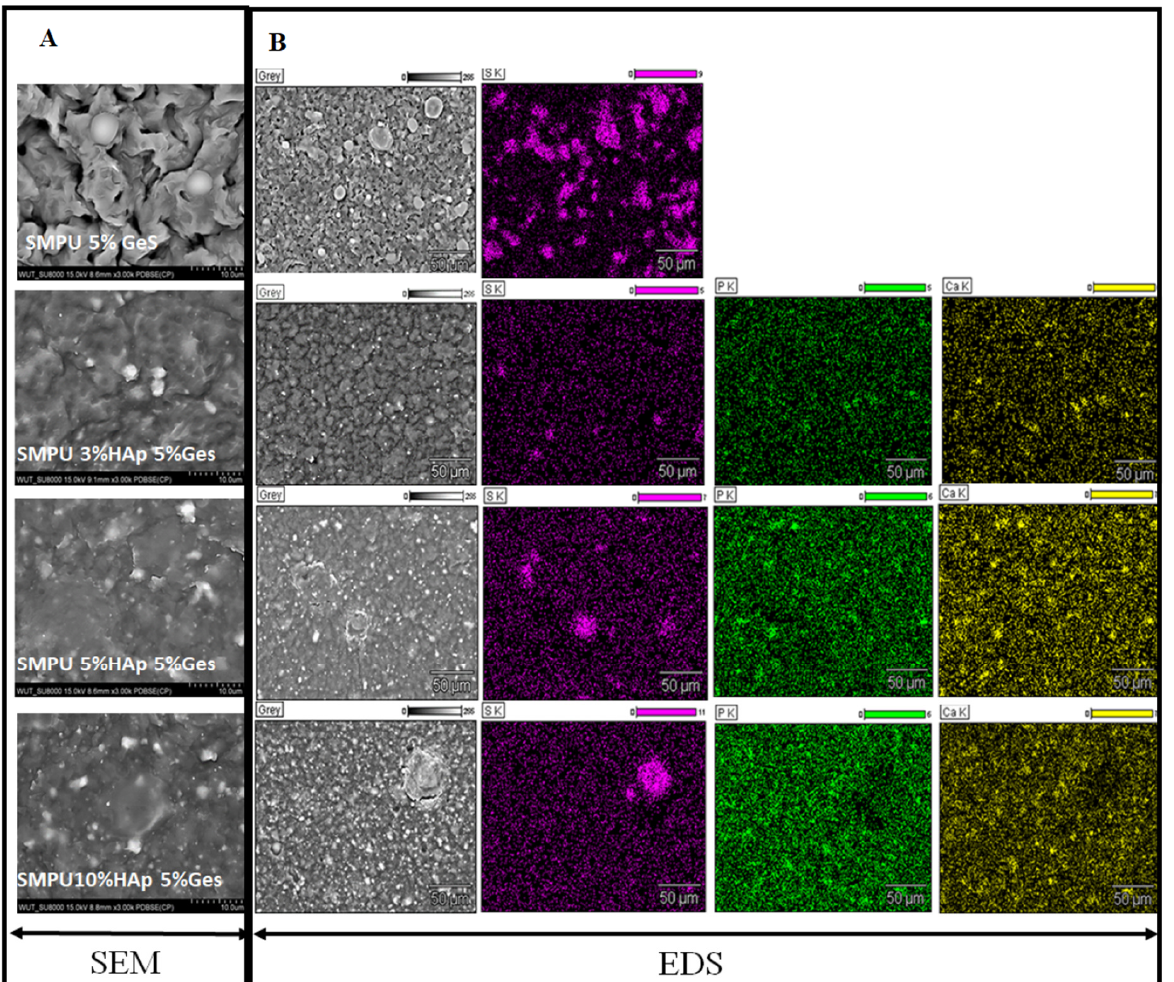
Figure 1. ( A ) SEM BSE images of composite surfaces with various contents of HA and 5 wt% of GeS. ( B ) EDS analysis showing distribution of S, Ca, P within PU matrix. Violet color—sulfur distribution originating from GeS, green—phosphor distribution from HA, yellow—calcium distribution that originates from HA.